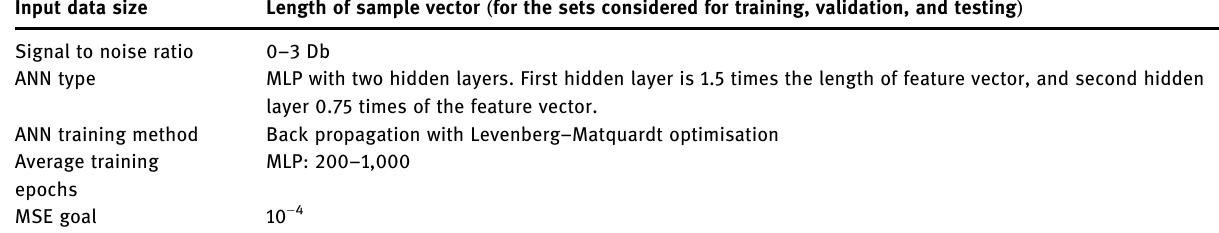
Table 5: ANN speci fi cations considered for the present study Input data size